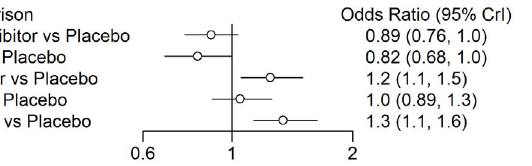
Fig. 4. A sample of the detailed comparison-wise forest plots available from the gemtc R package outlining odds ratio estimates from contributing studies, direct evidence and indirect evidence using treatments 5 (diuretic) and 6 (placebo) from the diabetes data.